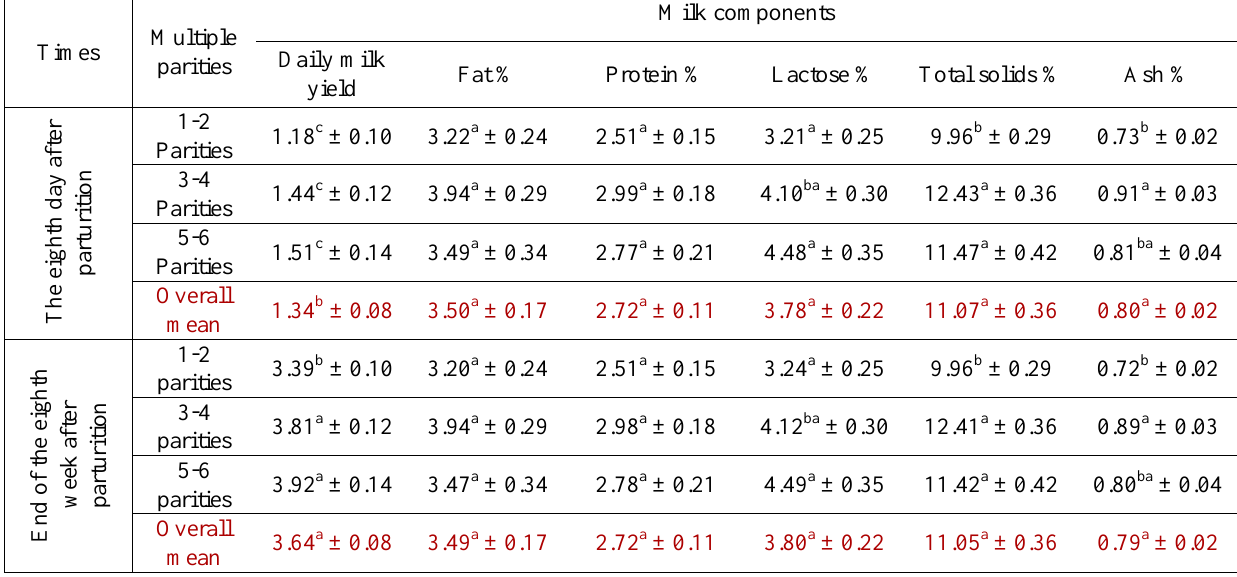
Table 3: The variation (mean ± S.E) of Maghrebi she–camels milk yield and components among different parities in the first and eight weeks after parturition